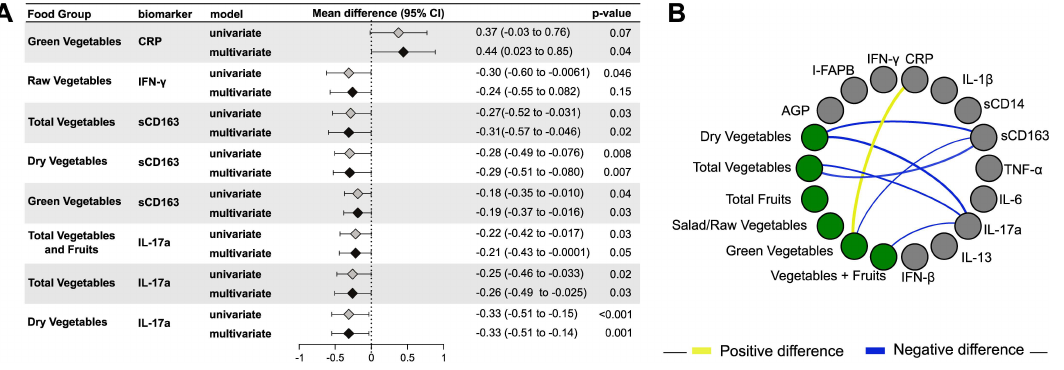
Figure 1. Association of vegetable and fruit intake with markers of inflammation. Using linear regression, the mean difference in log 2 concentration of each inflammation markers and 95% confidence intervals (95% CI) per unit (log e grams/day) change in total vegetable and fruit intake is shown in Figure 1. We further assessed the relationship with inflammation markers by unit change (log e grams/day) of (a) total vegetables and (b) fruits, along with sub-categories of vegetables: (i) dry vegetables, (ii) green vegetables and (iii) raw/salad vegetables. Only significant results ( p < 0.05) in univariable or multivariable analyses are shown in the forest plot (Figure 1 A ), with complete data shown in Supplementary Tables S2–S4 and S6–S8. The network graph (Figure 1 B ) shows statistically significant mean differences of inflammatory markers (gray nodes) for each food group (green nodes). Positive or negative mean differences are represented by yellow or blue edges, respectively. The size of the edges is proportional to log 2 mean differences. Only significant ( p < 0.05) multivariable models are shown in this chart. Univariable models are adjusted for average daily energy intake and multivariable models are adjusted for daily energy intake, HIV status, age, education, gestational age at sampling and current smoking status.